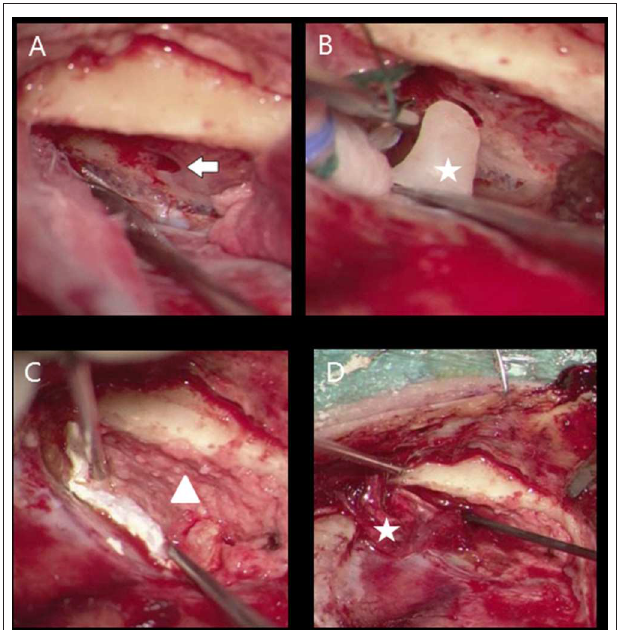
FIGURE 1 | Middle cranial fossa approach meningocoele right ear (A) defect tegmen tympani (flash), (B) bone wax obliteration bony defect (star), (C) coverage bony tegmen surface with bone powder (triangle) and dural defect with tachosil, (D) fascia (star) application between bony layer (bone dust) and tachosil (dura coverage).